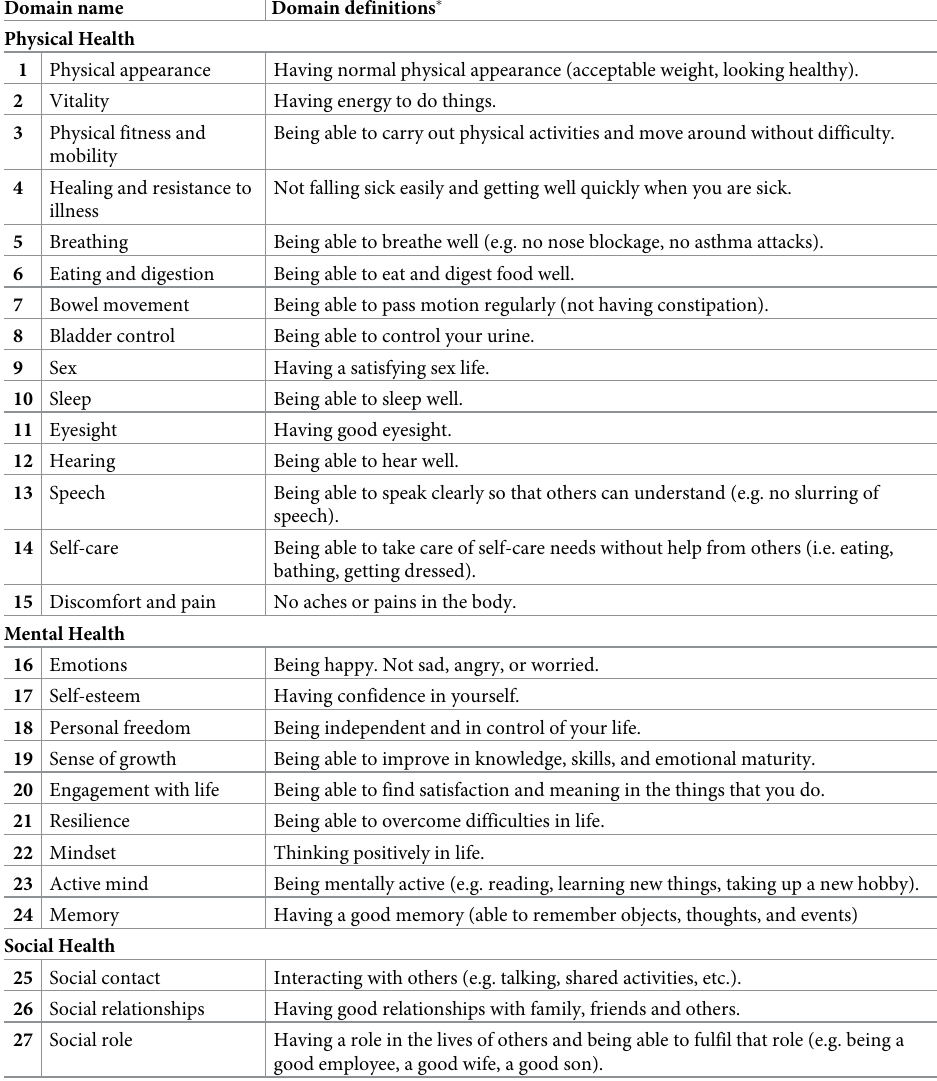
Table 2. Definition of the domains ranked in the community-based